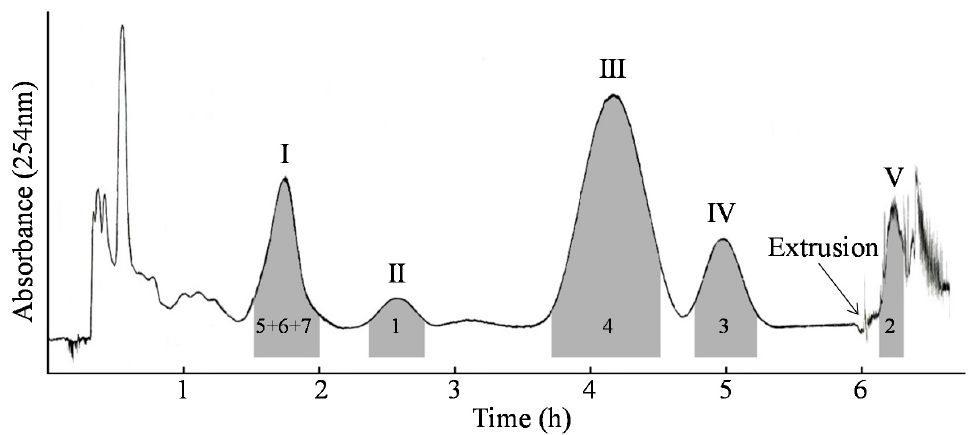
Figure 2. Chromatogram of the purchased total flavonoids from the leaves of C. pinnatifida by HSCCC. Solvent system: chloroform/methanol/water/ n -butanol (4:3:2:1.5, v/v ); Mobile phase: the lower; Revolution speed: 850 rpm; Flow rate: 5.0 mL/min; Sample size: 200 mg; Injection volume: 20 mL; Wavelength: 254 nm; Stationary phase retention: 62.8%.